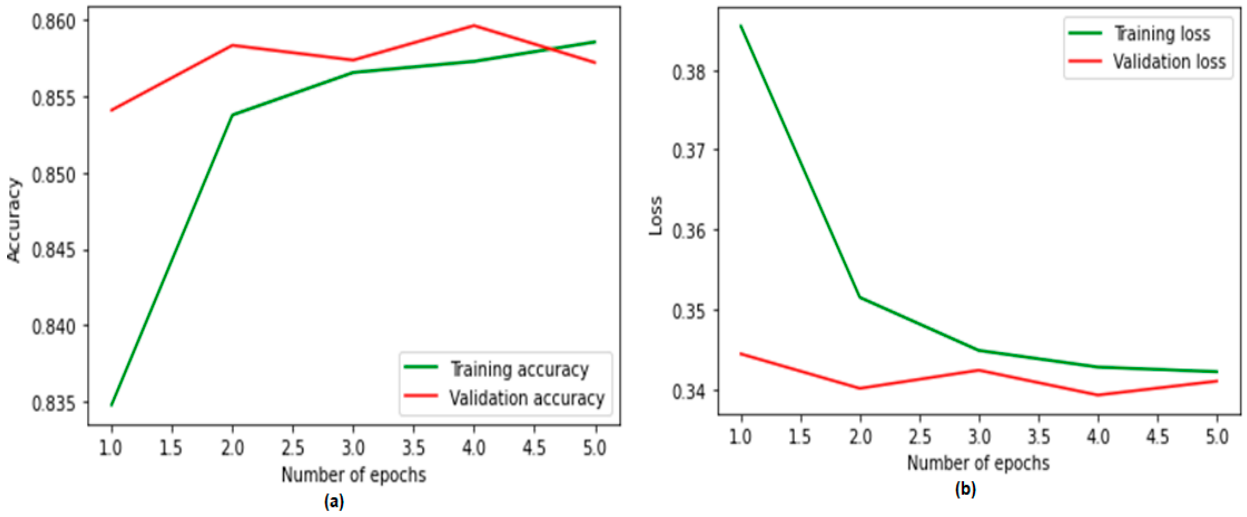
Figure 7. Training and validation ( a ) accuracy and ( b ) loss using LIWC features.